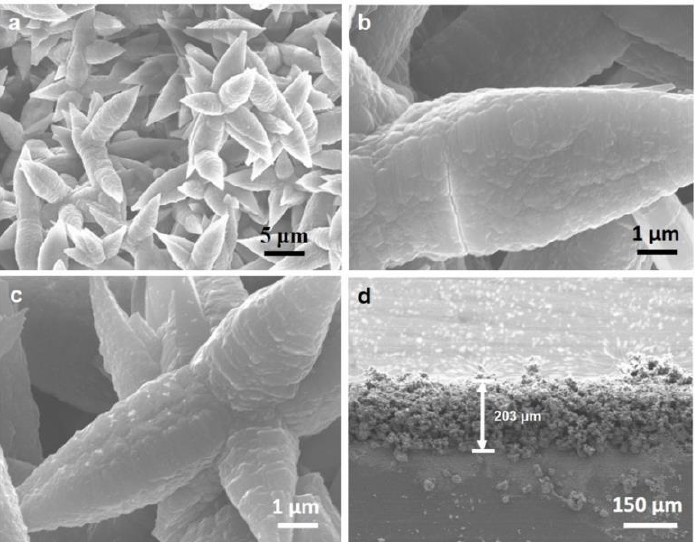
Figure 2. ( a , b ) SEM image of the Al(OH) 3 layer, ( c ) on-site MAPbBr 3 perovskite on the Al(OH) 3 layer, and ( d ) section view of the Al(OH) 3 layer.